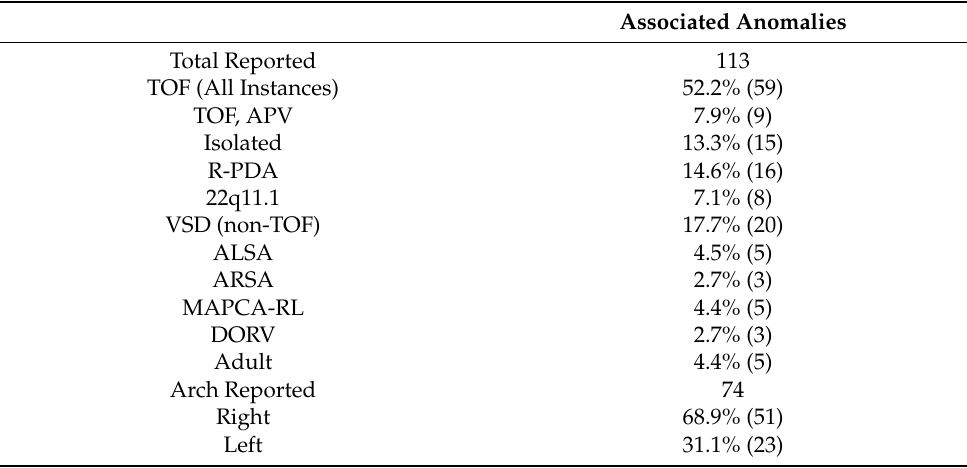
Table 2. Associated anomalies in addition to anomalous origin of left pulmonary artery from ascending aorta. AR(L)SA = Aberrant Right (Left) Subclavian Artery, DORV = Double Outlet Right Ventricle, MAPCA-RL= Major Aortopulmonary Collateral Vessels Supplying the Right Lung, TOF = Tetralogy of Fallot, VSD = Ventricular Septal